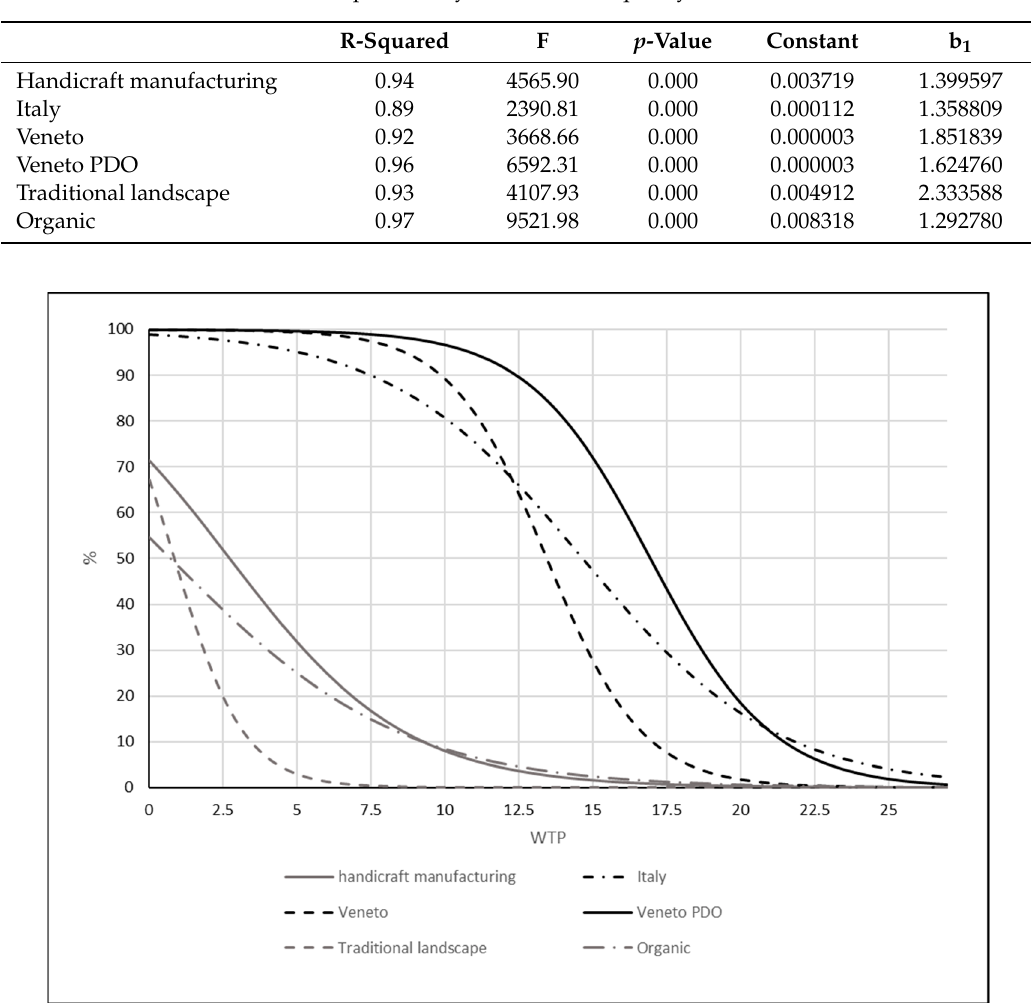
Figure 1. Complementary cumulative distribution functions. WTP = Willingness to Pay; PDO = Protected Designation of Origin.